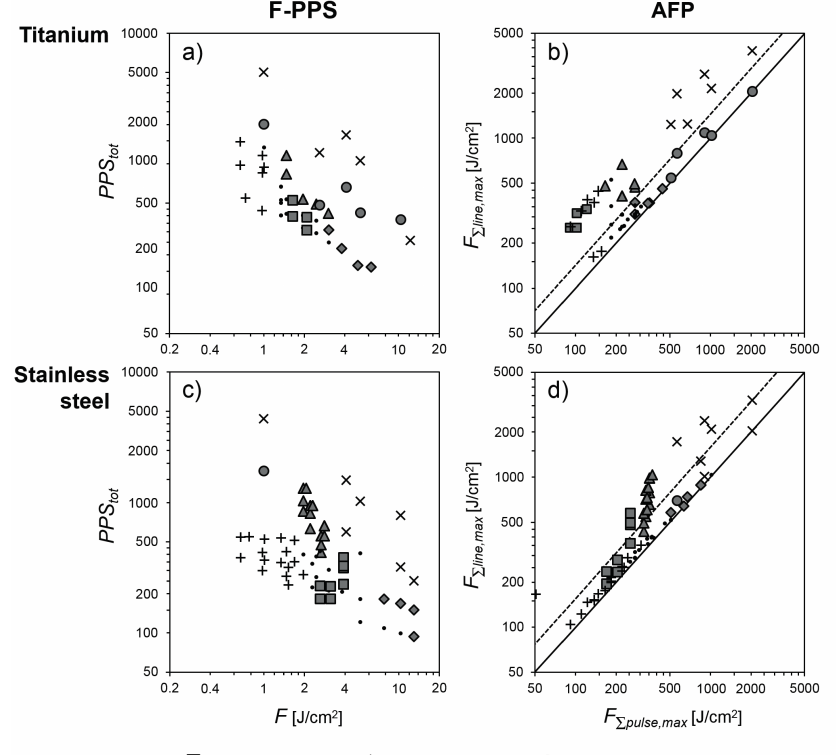
Figure 12. Micromachining parameters for different surface structures in terms of two parameters for F-PPS and AFP model [48]. The dashed line indicates the transition from wavy-to-flat 𝐹𝐹 ∑𝑙𝑙𝑙𝑙𝑙𝑙𝑝𝑝